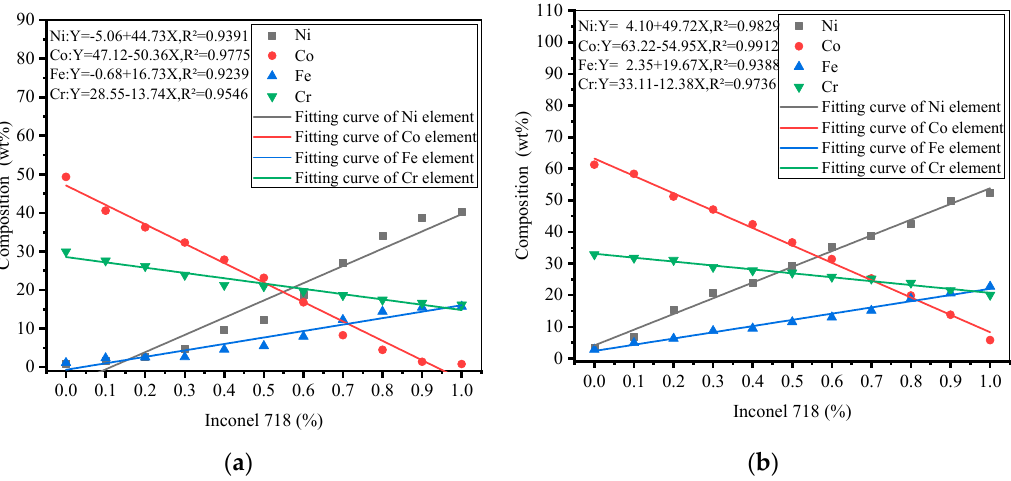
Figure 7. Element distribution of LMD forming FGM thin - walled parts: ( a ) 20 °C, ( b ) 300 °C.